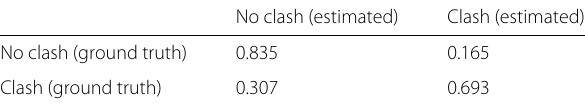
Table 4 Confusion matrix for the vocal clash detection experiment (No clash: 10167 crossfades; Clash: 1524 crossfades) No clash (estimated) Clash (estimated) No clash (ground truth) 0.835